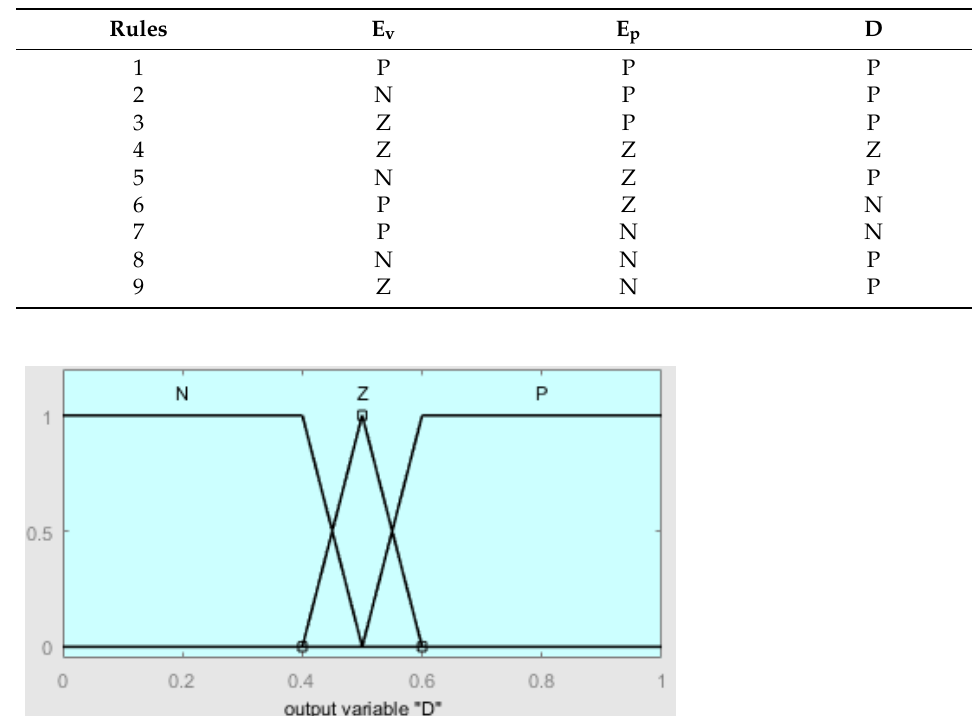
Figure 6. Linguistic variable E P (k). Table 2. Rules of inference.